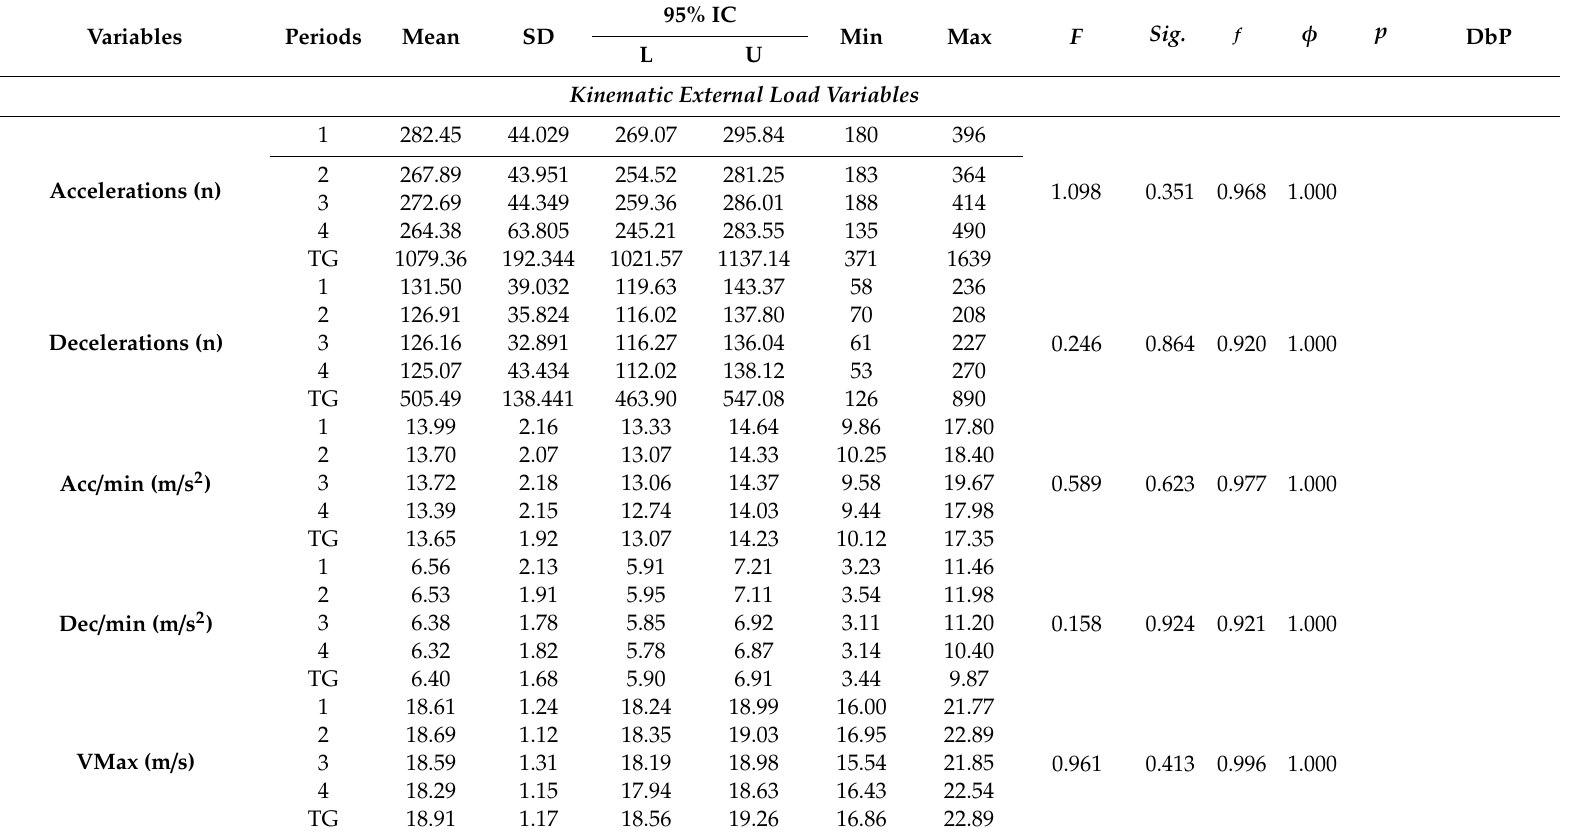
Table 3. Descriptive and Inferential Results of the External Load Variables (Kinematic